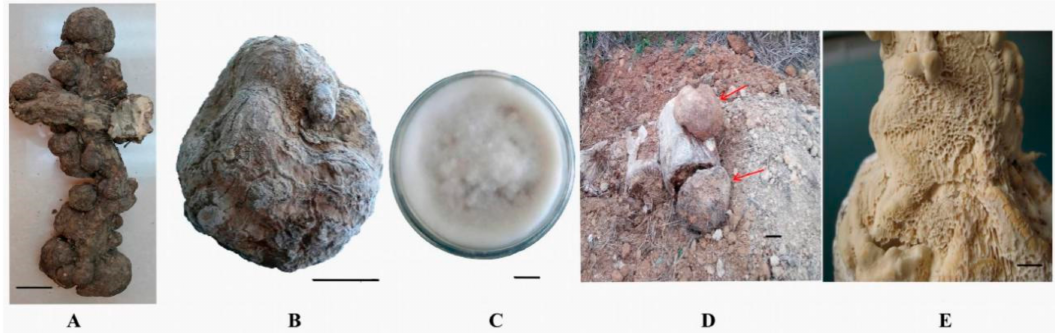
Figure 3. Wolfiporia cocos . ( A ) natural sclerotium of Wolfiporia cocos ; ( B ) bionic cultured sclerotium; ( C ) colony on PAD medium; ( D ) pollution-control cultured sclerotium; ( E ) cultured fruiting body. Bars: A, B, D = 5 cm; C, E = 1